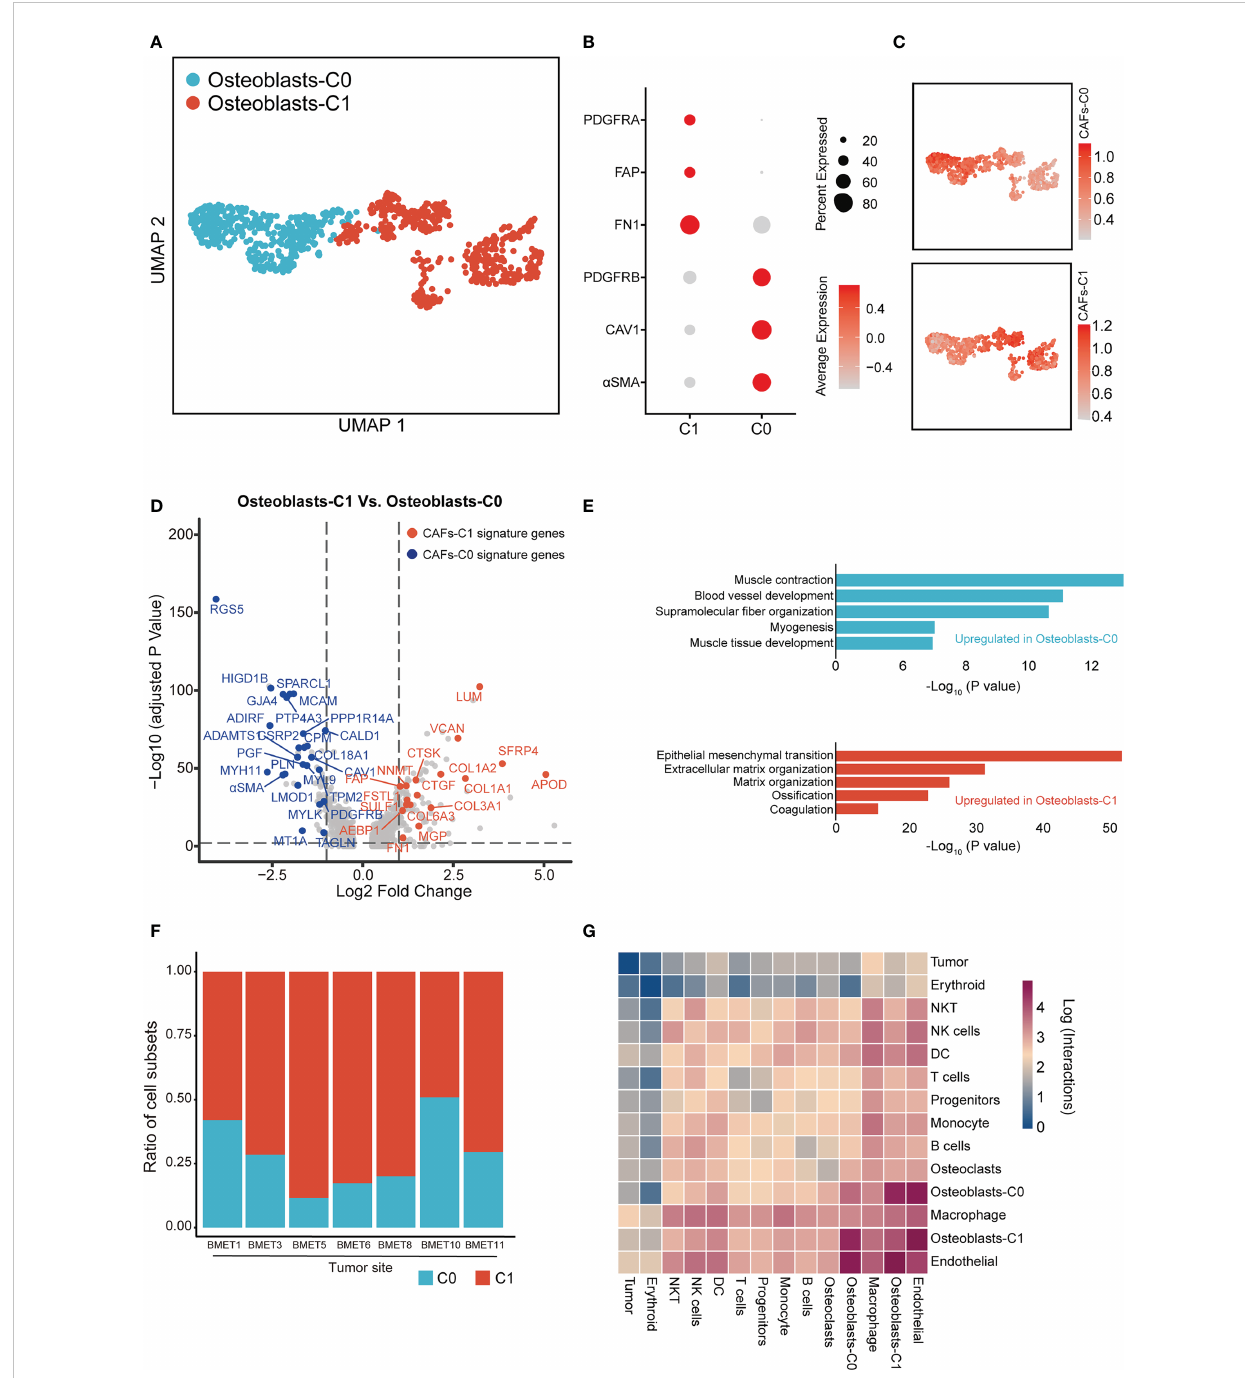
FIGURE 4 Identi fi cation of osteoblasts subtypes in bone metastatic lesions. (A) UMAP plot of osteoblasts in 7 bone metastatic prostate cancer samples. Osteoblasts subtypes were demarcated by colors. (B) Dot plot showing the expression levels of representative CAFs-C0 and CAFs-C1 signature genes in each osteoblasts subtype. (C) UMAP plot showing the CAFs-C0 and CAFs-C1 signature scores in osteoblasts. (D) Volcano plot displaying the DEGs between osteoblasts-C1 versus osteoblasts-C0. CAFs-C0 and CAFs-C1 signature genes were represented in blue and red, respectively. (E) Top 5 enriched pathways for osteoblasts-C0 and osteoblasts-C1. (F) Relative abundance of each osteoblasts subtype in 7 bone metastatic prostate cancer samples. (G) Heatmap showing the number of potential cell-cell interactions between osteoblasts and all other cell subtypes predicted by